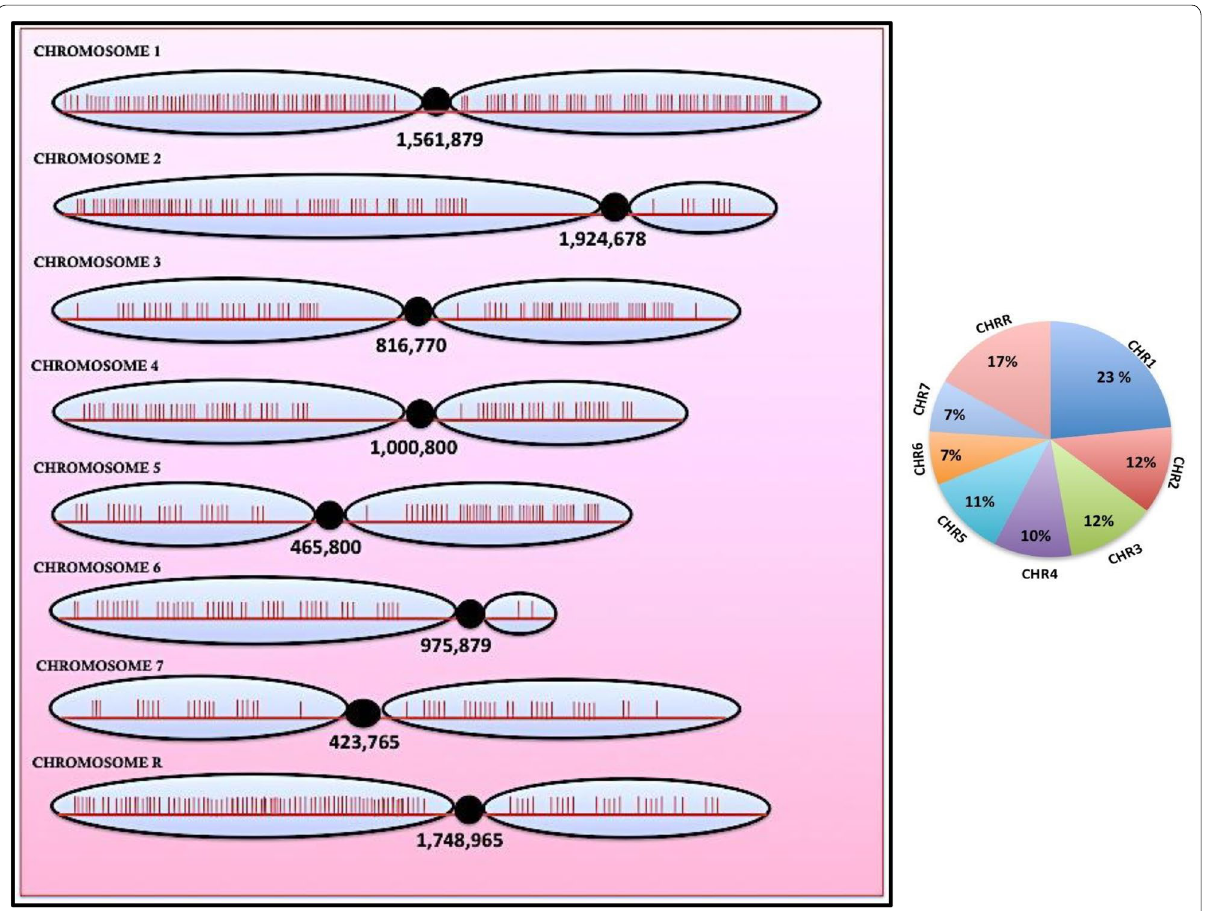
Fig. 2 Distribution of Hsf1 binding sites—the distribution of Hsf1 binding sites in the eight Candida albicans chromosomes is represented here. The red vertical bars represent the positions of the Hsf1 binding sites on each chromosome. The black circle indicates the location of the centromere. The pie chart on the right indicates the percentage of Hsf1 binding sites on each